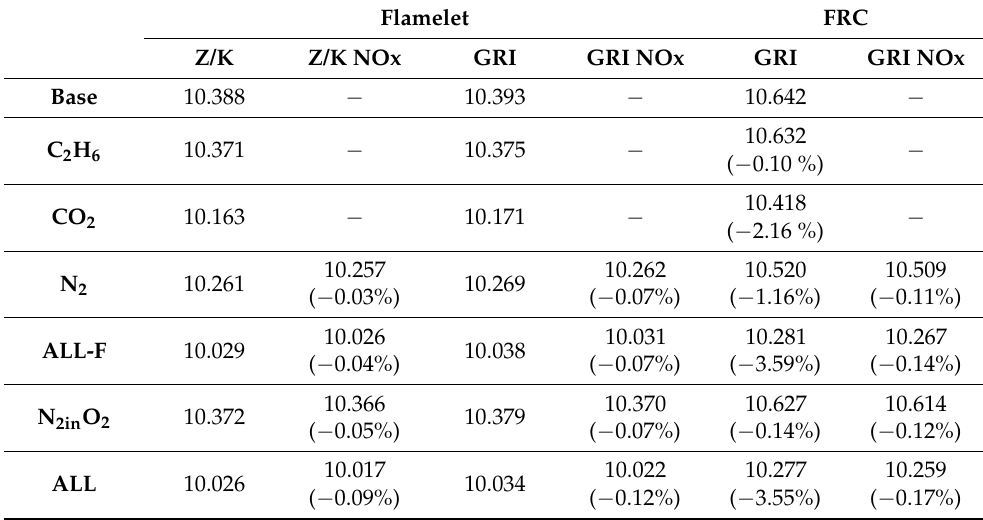
Table 14. Pressure in [MPa] at the chamber wall (x = 0.171 m) for different pollutants of the fuel and/or the oxidizer and different combustion modelling at 10 MPa (CFD